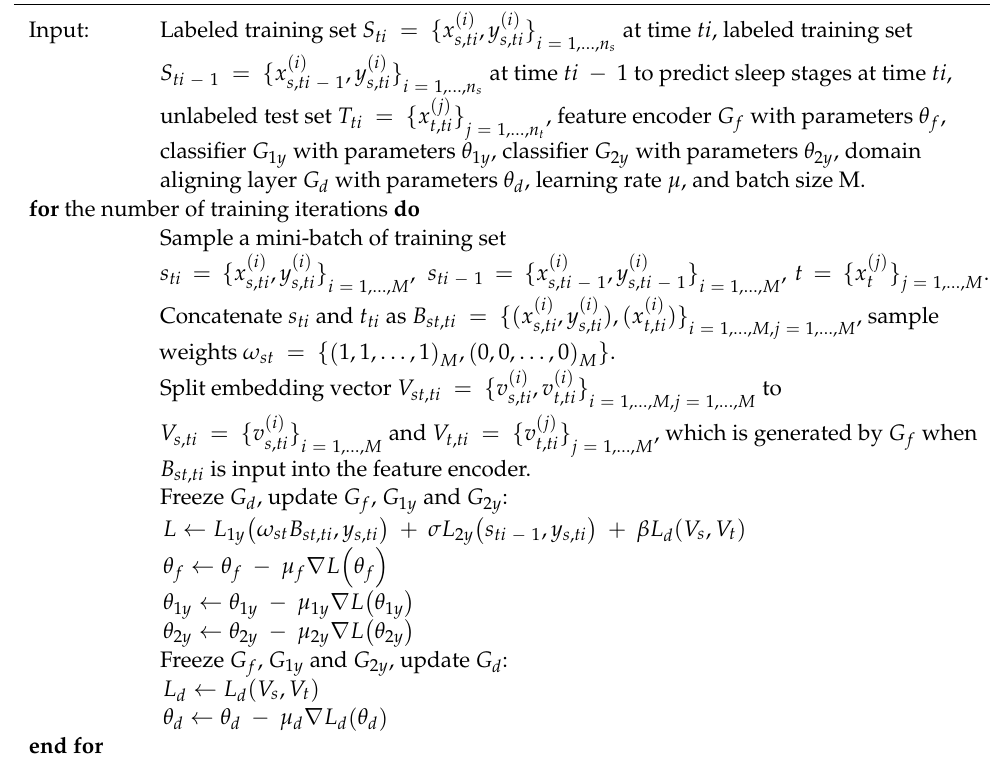
Algorithm 1 : The Domain Adaptation Supervised Training